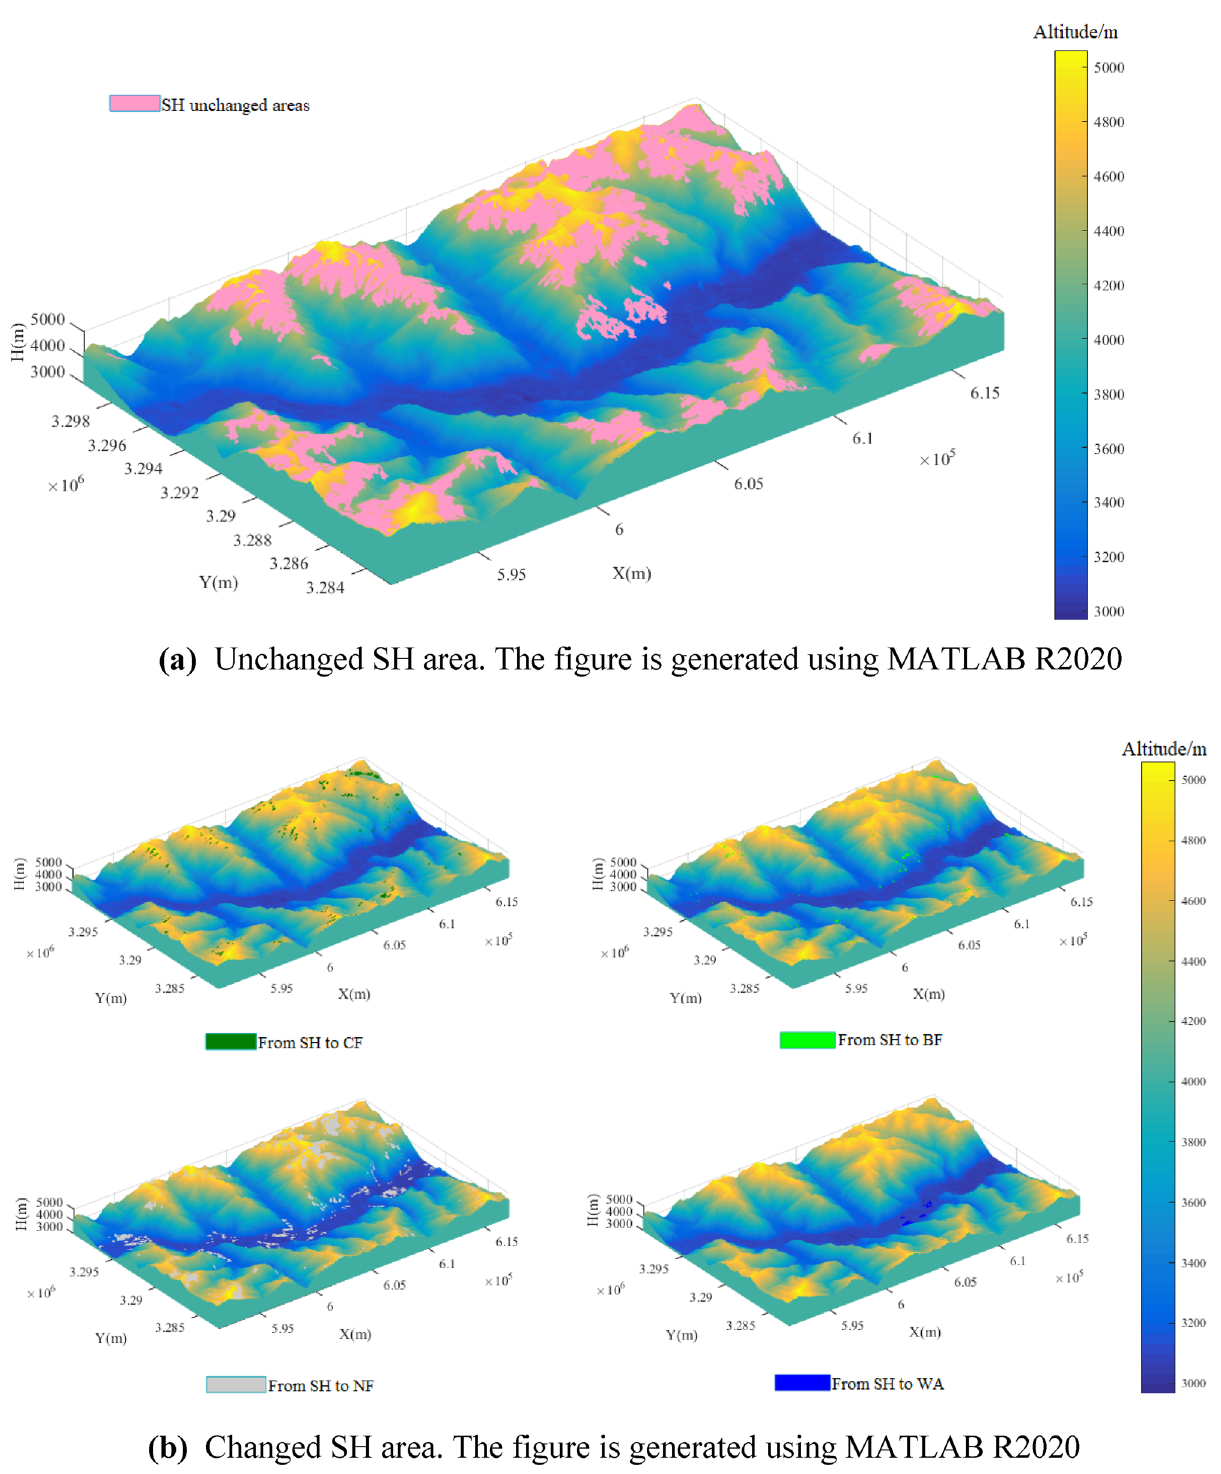
Figure 9. (a) Unchanged SH area. The figure is generated using MATLAB R2020 (http:// www. mathw orks. com). (b) Changed SH area. The figure is generated using MATLAB R2020 (http:// www. mathw orks.